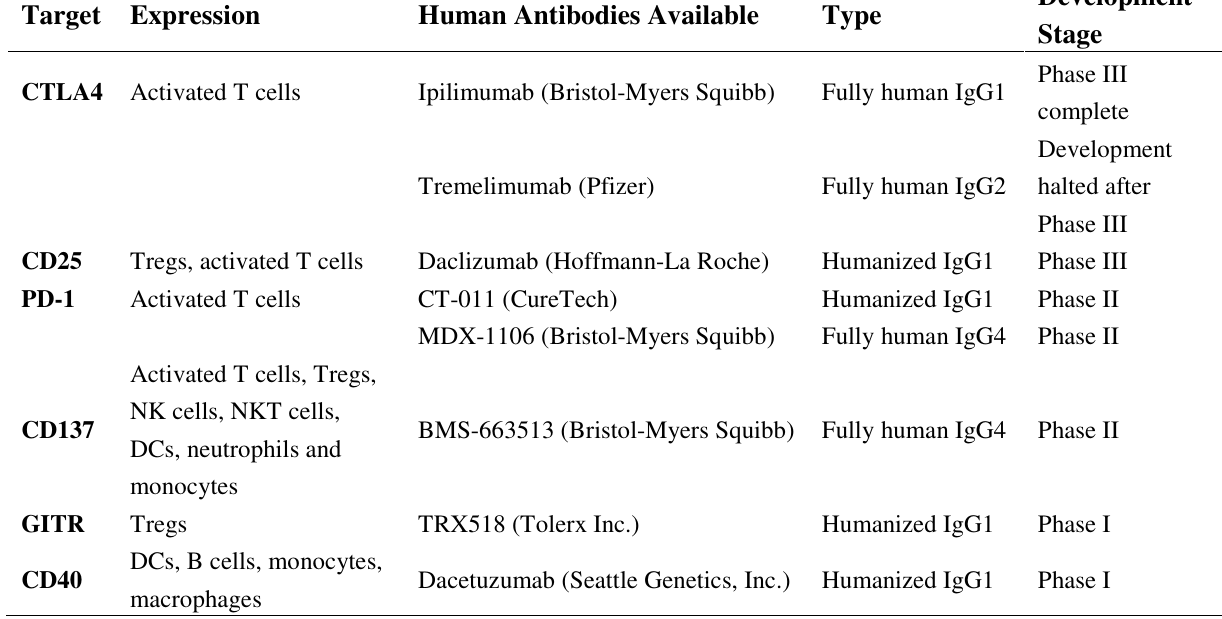
Table 4. Immune modulatory monoclonal antibodies in development for humans (adapted from